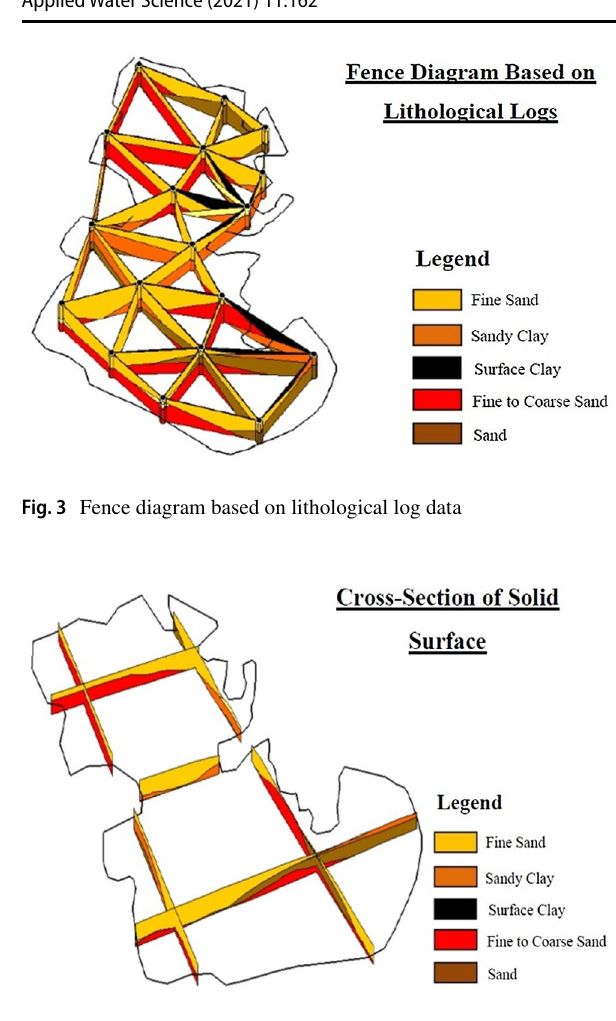
Fig. 4 Cross section of the solid